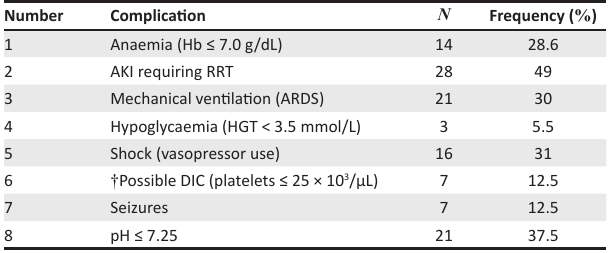
TABLE 6: Documented World Health Organization indicators 15 of severe malaria and poor